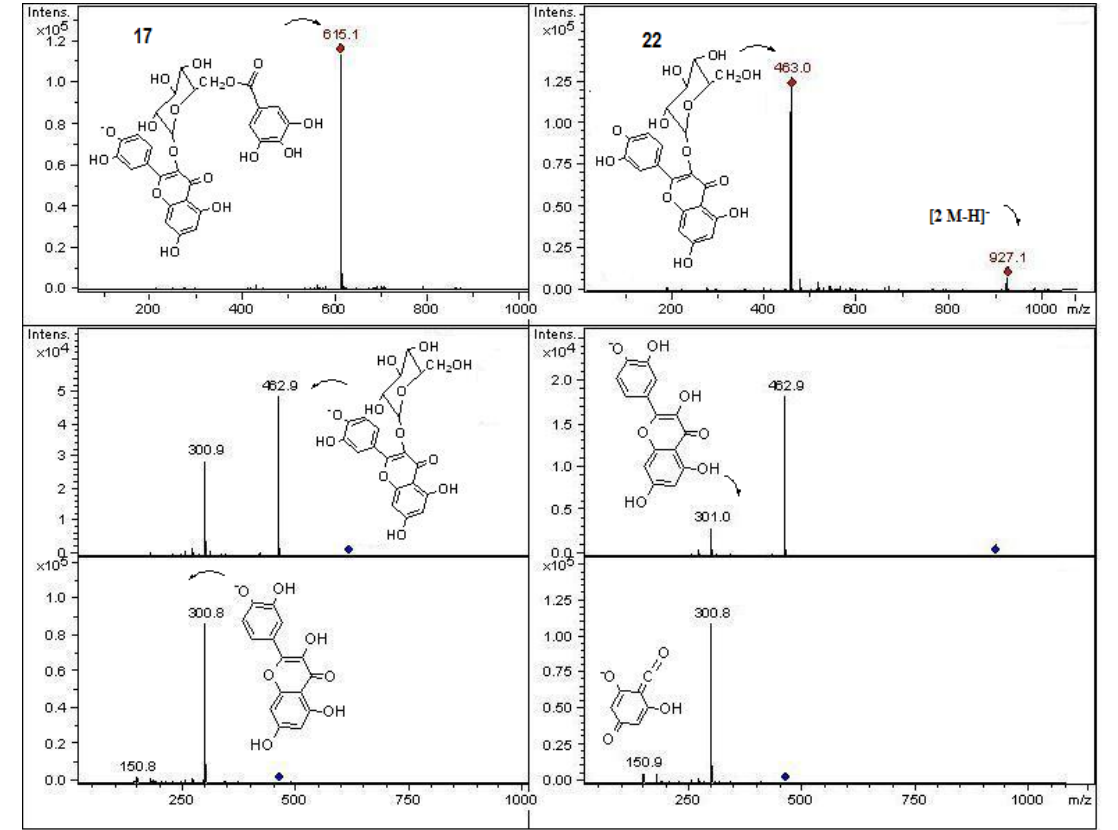
Figure 8. Structures, fragmentation, full ESI-MS and MS-MS spectra of peaks 17 and 22 .